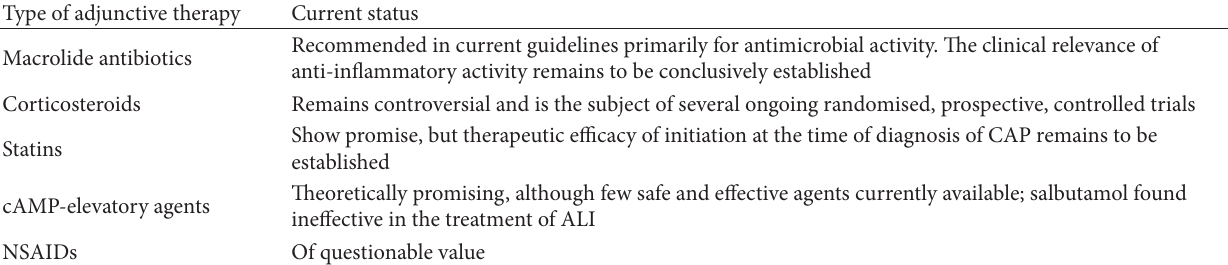
Table 3: Adjunctive anti-inflammatory therapies in